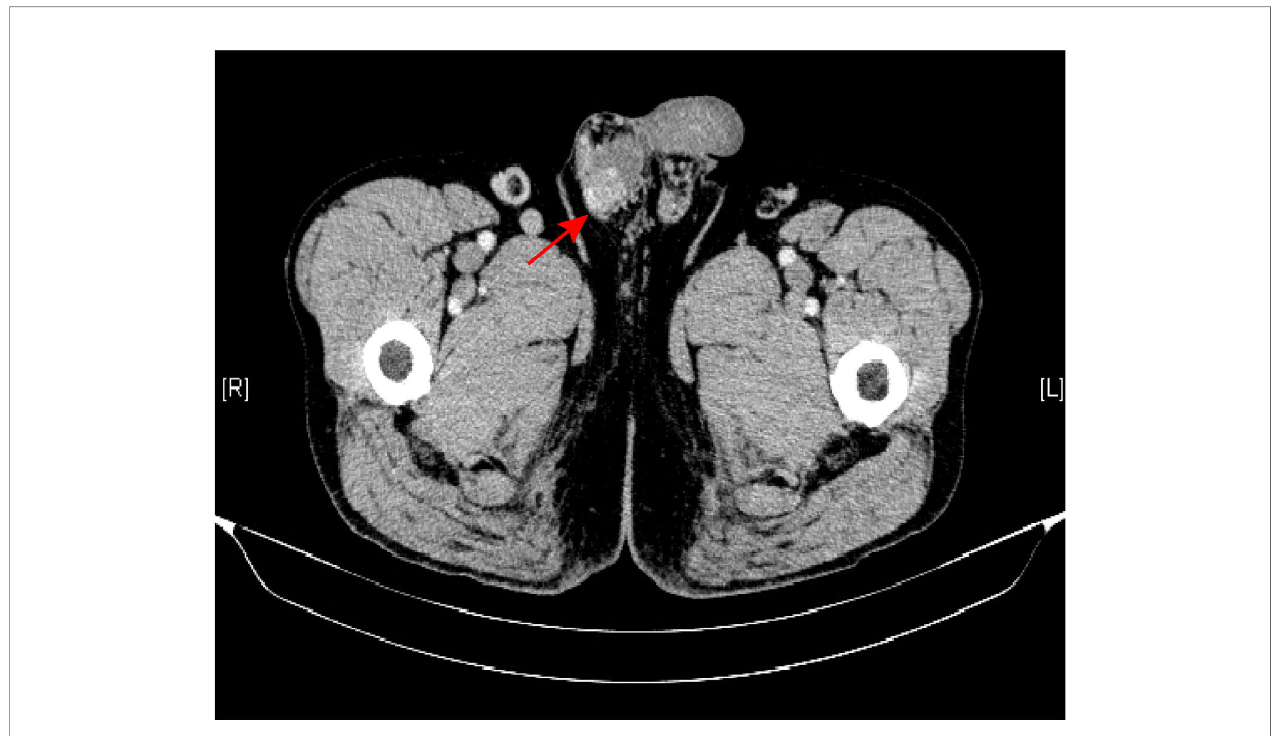
FIGURE 1 | Enhanced computed tomography of the scrotum showed a nodular hyperdense shadow in the right epididymis